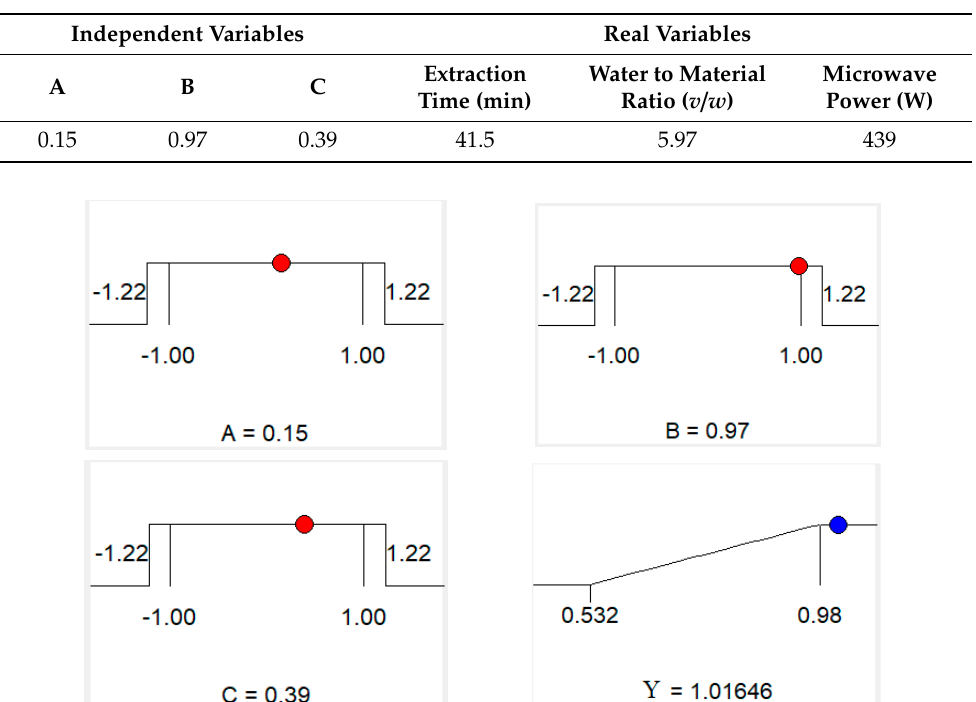
Table 4. The values of the independent variables and real variables.